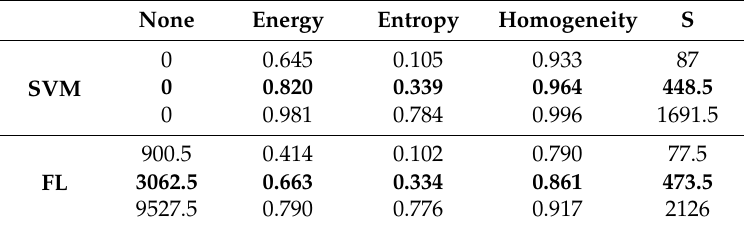
Table 5. Quantitative indices for classification results obtained by the SVM and FL HCA. The dataset consists of 100 PPIs collected by Polar 55C at 1.6 ◦ elevation angle extracted randomly from the entire dataset. The CIs for each index are derived from the 10th, 50th , and 90th percentiles are listed for each classification